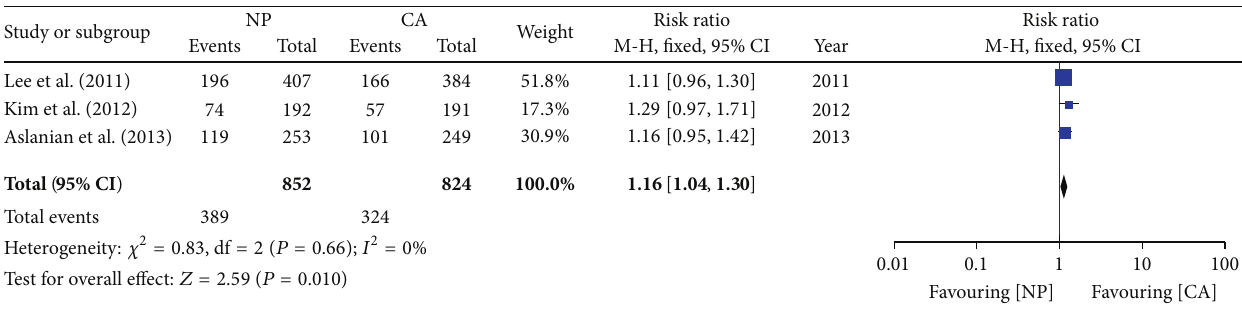
Figure 4: Forest plot on the adenoma detection rate comparing NP versus